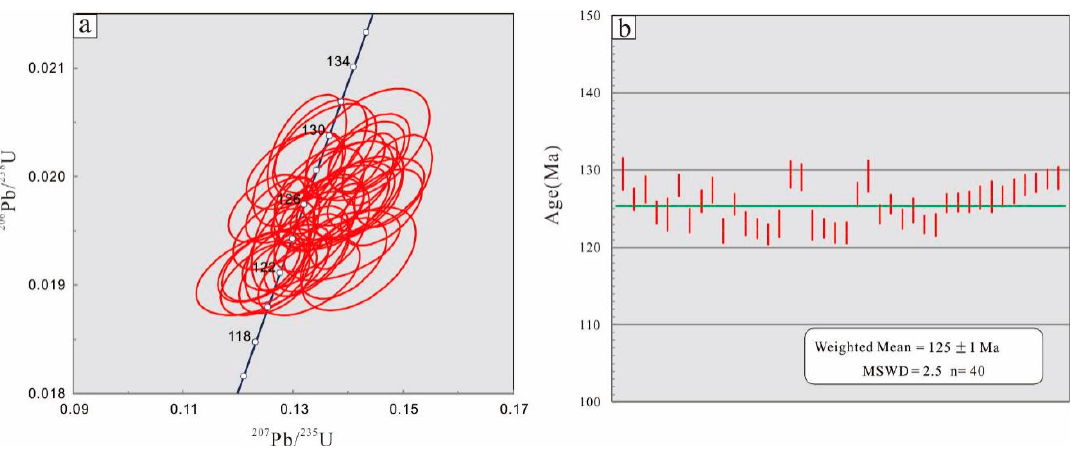
Figure 4. ( a ) Zircon U-Pb concordia and ( b ) weighted mean age diagrams for the Xianglushan biotite granite.